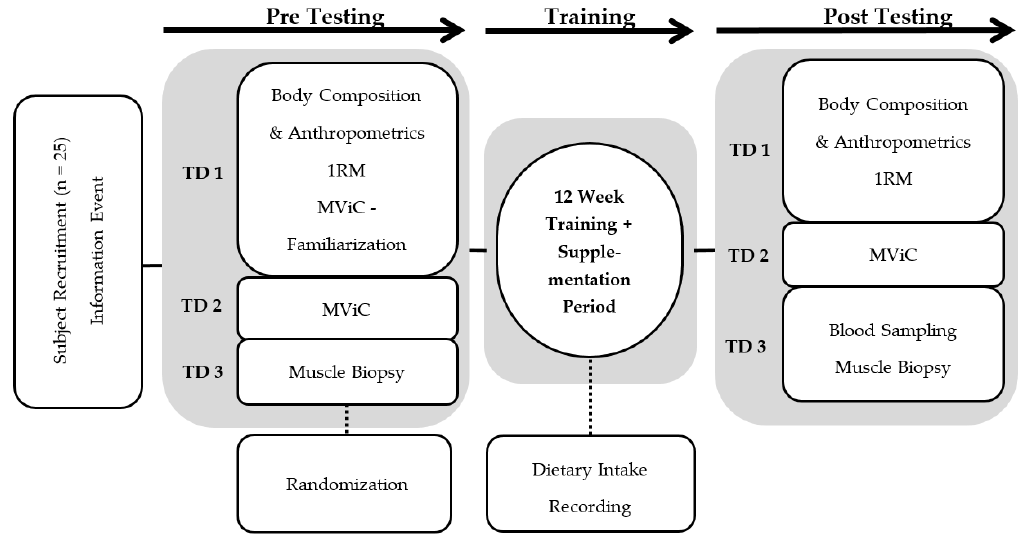
Figure 1. Flow chart describing the experimental design. Pre- and post-testing consisted of three test days (TD1–3) separated by a 12-week intervention period with collagen or placebo supplementation each day and hypertrophy resistance training three days per week. MViC: Maximal voluntary isometric contraction; RM: Repetition Maximum.